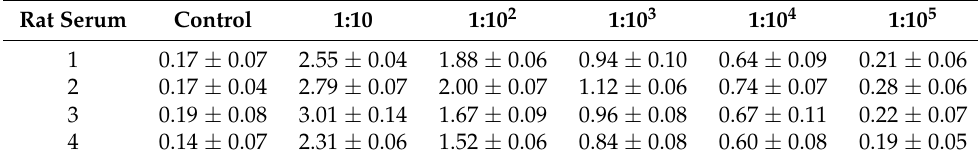
Table 2. Serum of the rat immunized with bLF was assayed by ELISA at OD 450 nm (mean ± SE).